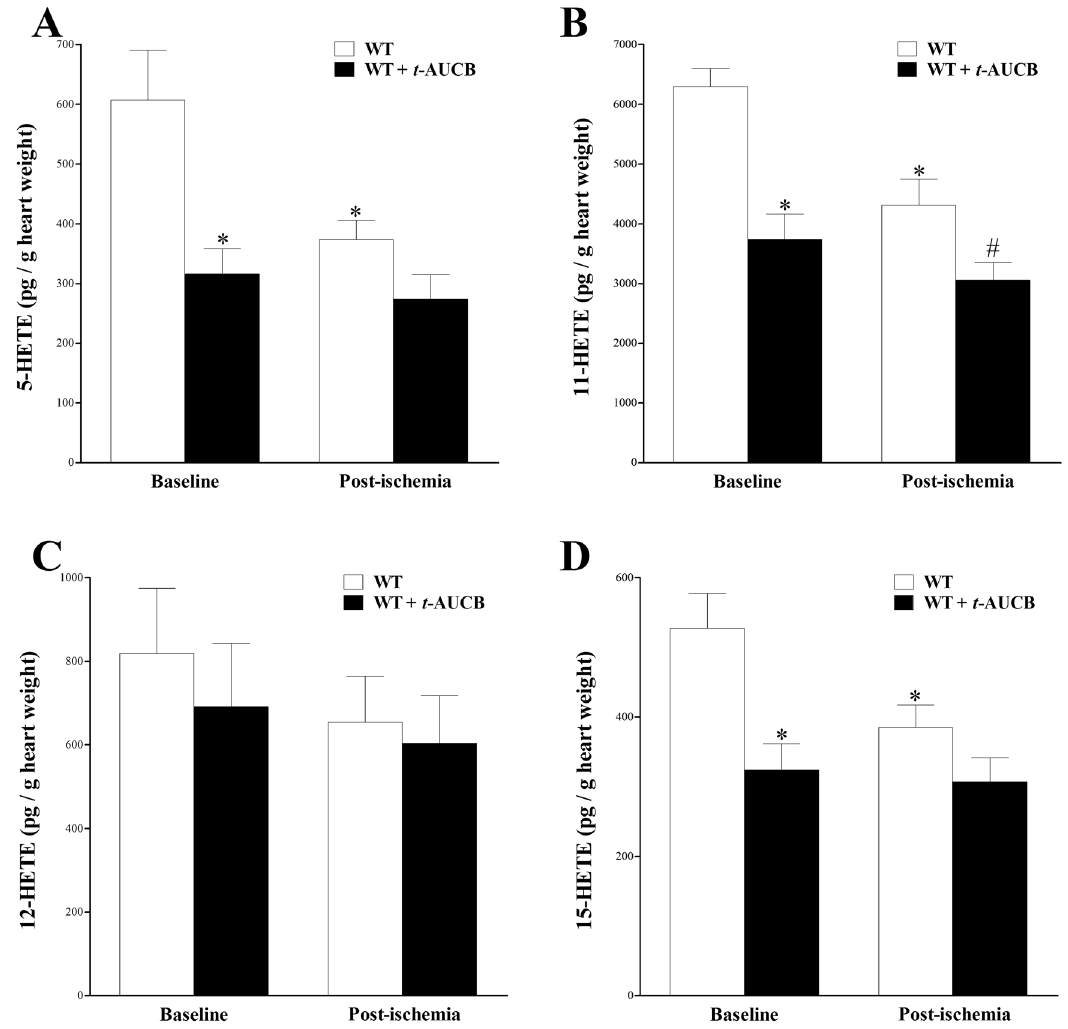
Fig 4. LC – MS/MS analysis of 5-, 11-, 12- and 15-HETE levels in WT and t- AUCB-treated WT mouse heart perfusates at baseline (pre-ischemia) and post-ischemia. In WT mice, 5-, 11-, 12- and 15-HETE levels decreased post-ischemia compared to baseline, but this was only significant for 5-HETE (A), 11-HETE (B), and 15-HETE (D) (p < 0.05). The same mid-chain HETEs had a decreasing trend post-ischemia compared to baseline in t- AUCB-treated WT mice, but this was not significant (p > 0.05, A-D). Treatment with t -AUCB decreased HETE levels in WT mice, which was significant for 5-HETE (A), 11-HETE (B) and 15-HETE (D) levels at baseline (p < 0.05), and in 11-HETE levels post- ischemia (p < 0.05, B). * p < 0.05 versus baseline WT. # p < 0.05 versus post-ischemia WT. n =